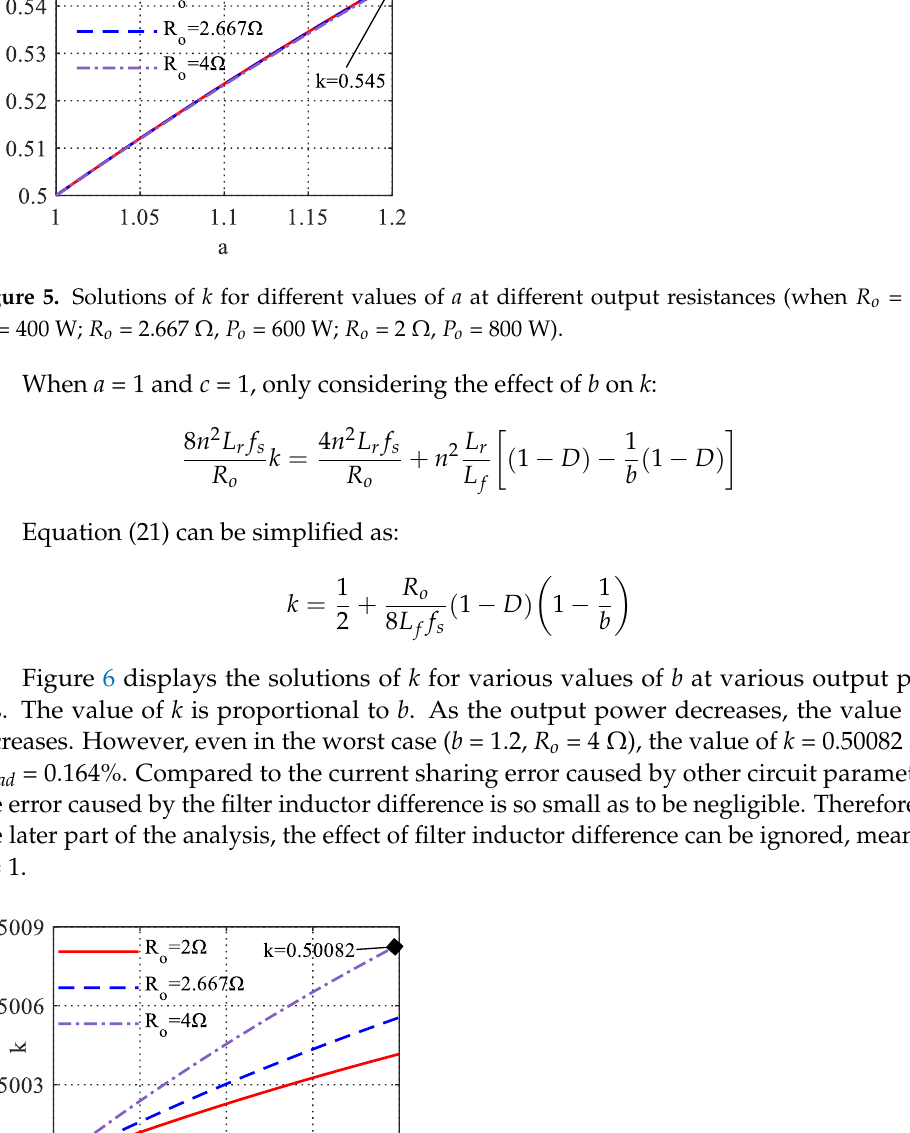
8 of 24 Table 2. Values of PSFB-related parameters. Parameter